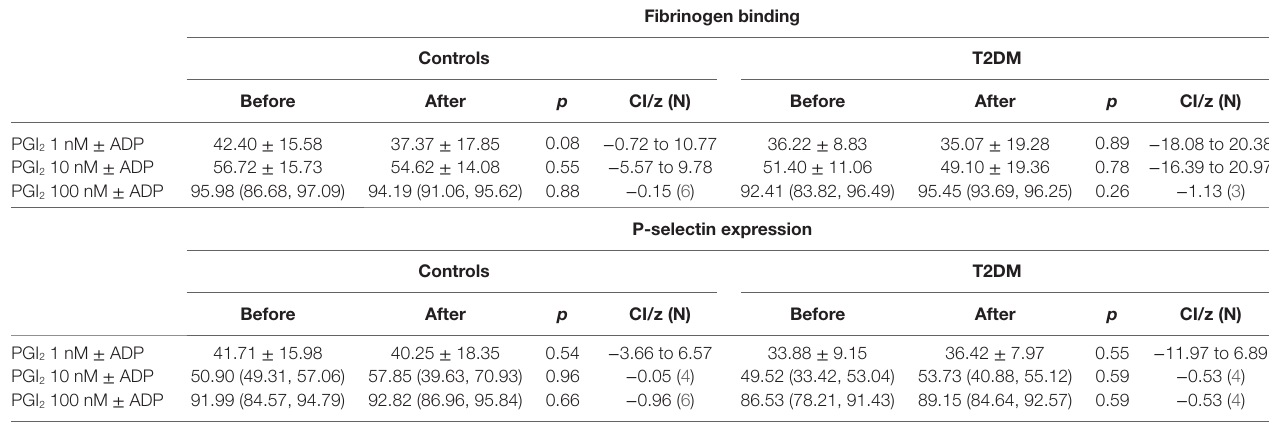
Table 4 | Platelet sensitivity to PGI 2 prior to and after the relative hypoxia of the simulated flight (SF) intervention showing no difference in deactivation of the ADP activated platelets between controls and patients with type 2 diabetes